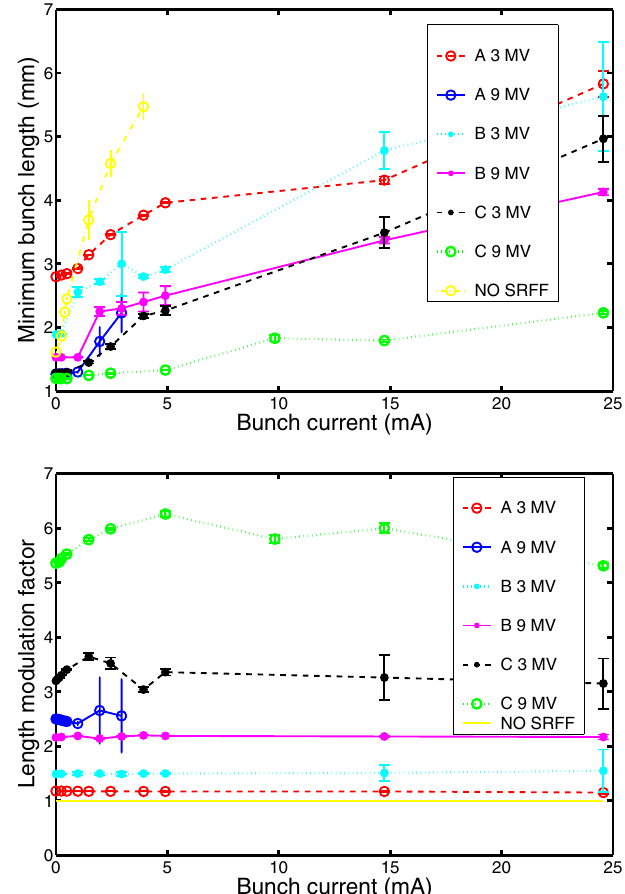
FIG. 12. (Color) Minimum bunch length and length modulation factor as a function of current up to 25 mA, under the effect of all the